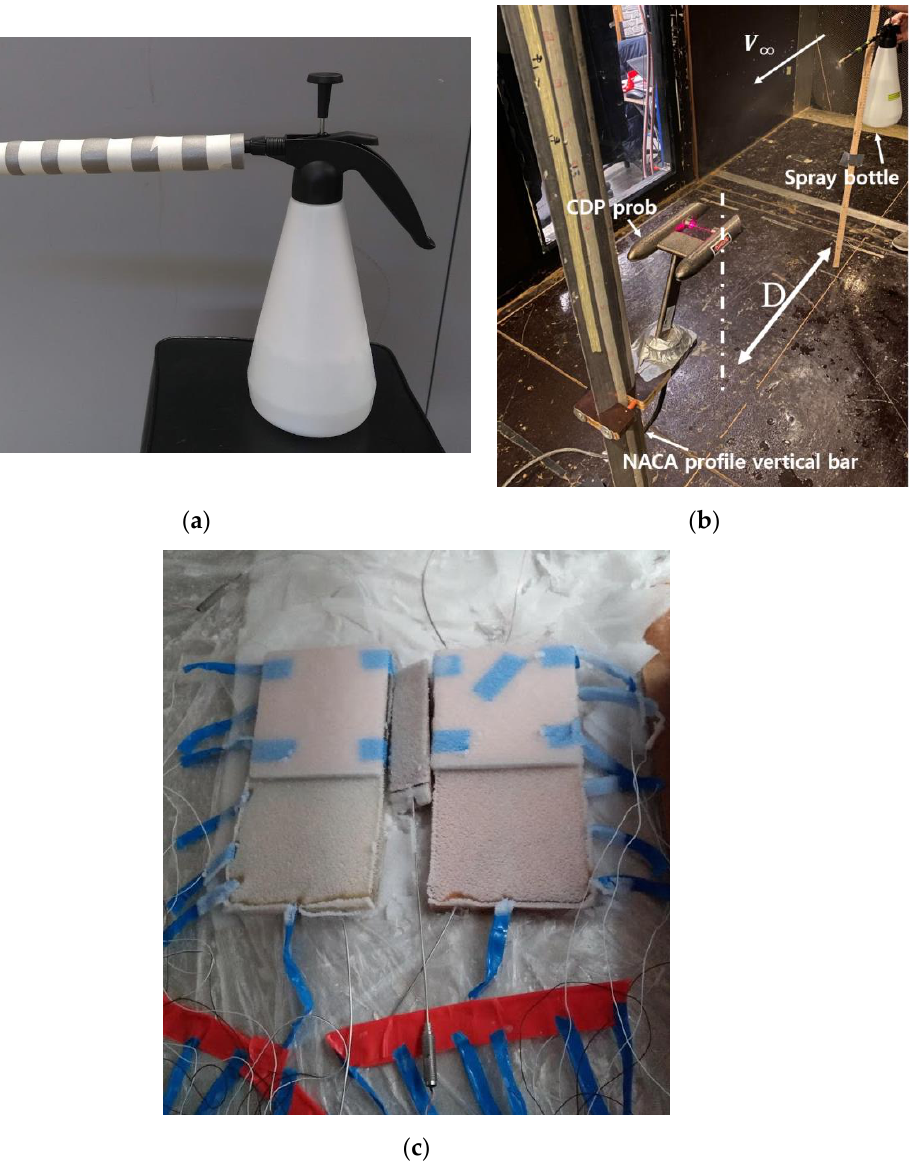
Figure 5. ( a ) Modified spray gun showing nozzle extension and insulation, ( b ) water droplet characteristic measurement set-up, ( c ) Ice formation on sensors showing rime ice accretion.